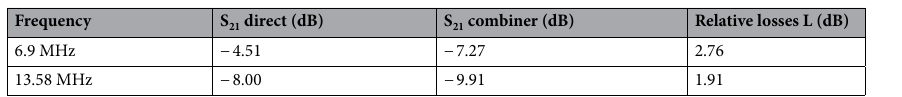
Table 1. S21 parameter of the combiner and the direct transmission; and the relative losses produced by the textile dual-combiner